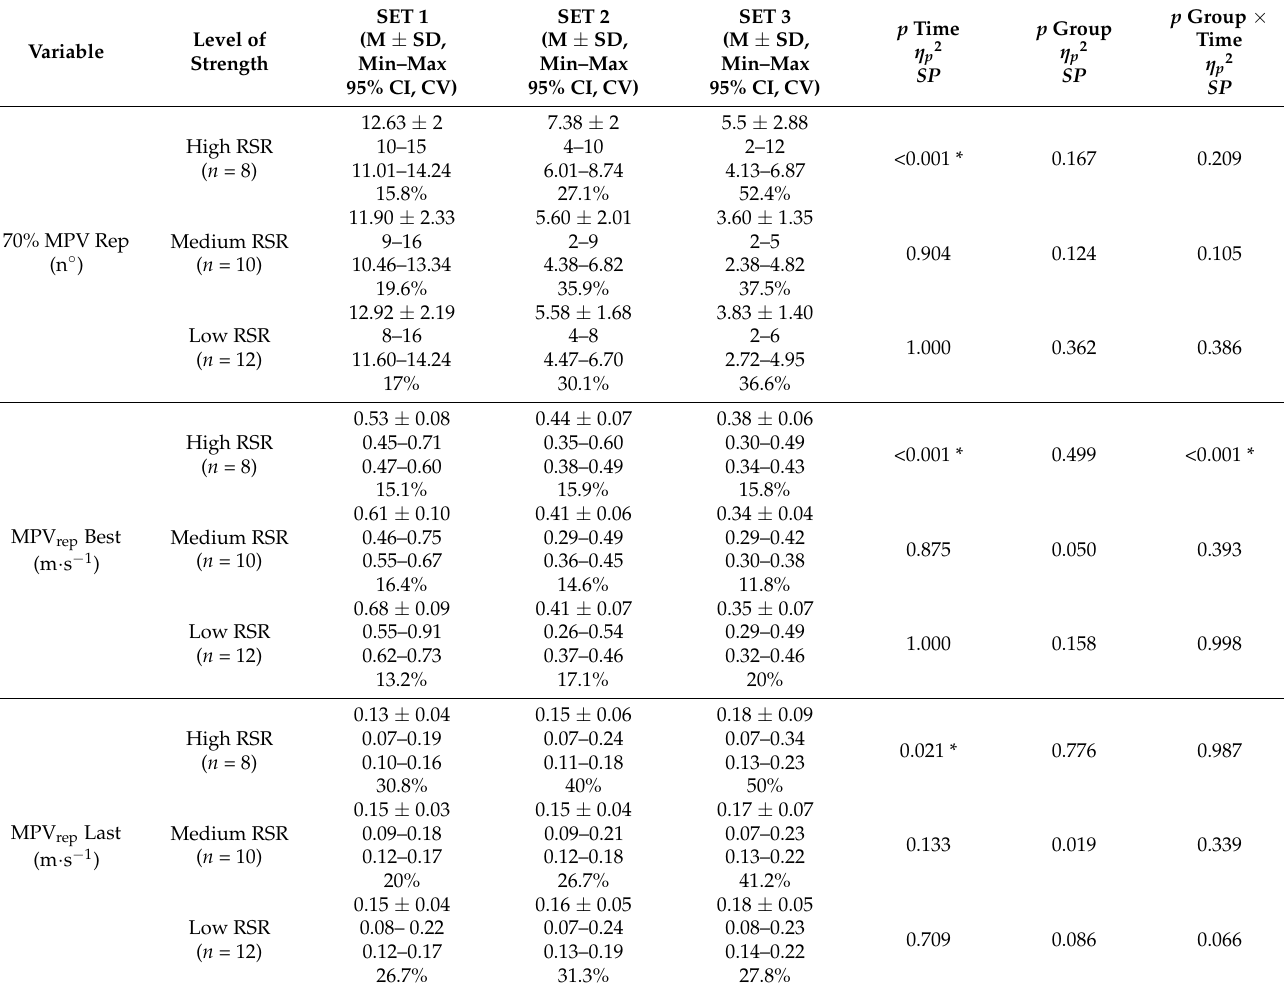
Table 2. Data related to the number of repetitions, the highest and the last repetition of the bench press exercise protocol with a load of 70% MPV obtained in the 1RM test for each